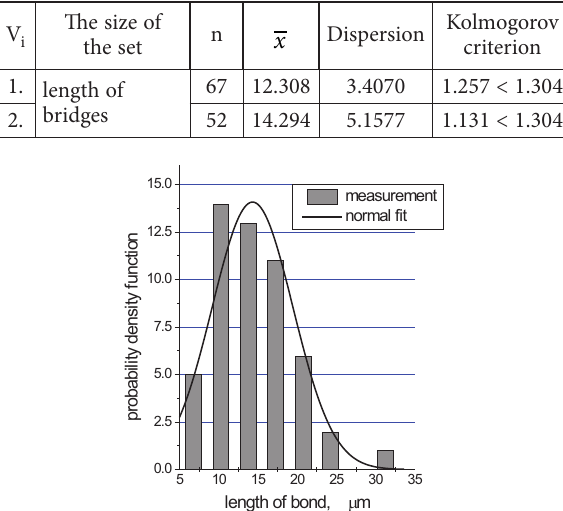
Figure 4. Diffuse fusion of fibers on the grain boundary (1) with pores (2) Table 2. Parameters of statistical treatment of diameters of the length of bridges between fibers